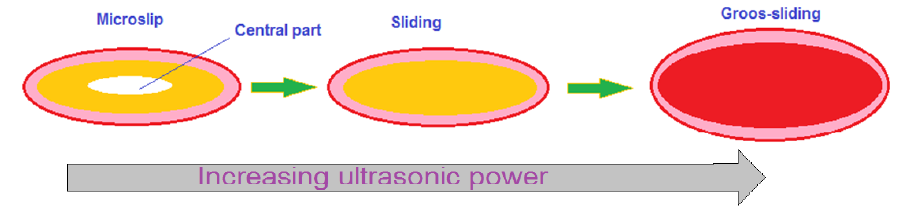
Figure 12. Ultrasonic bonding model of wedge bonding.